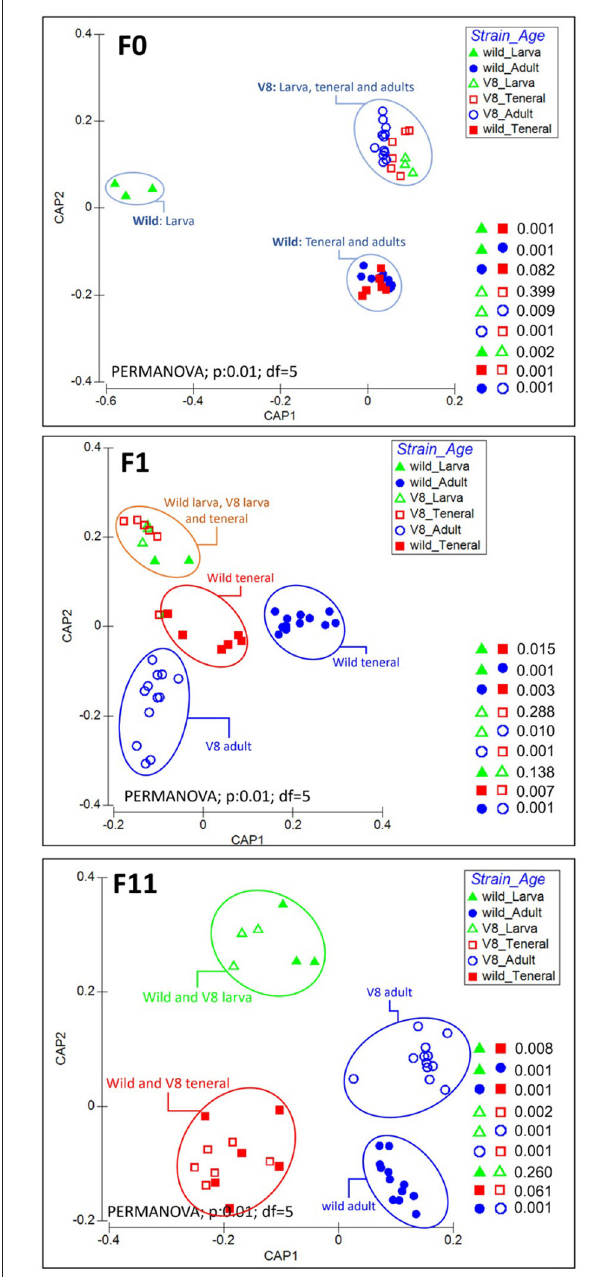
FIGURE 8 | Changes in the bacterial community structure associated with the guts of larva, teneral, and adults originated from Vienna 8 FD-GSS (V8) and wild C. capitata stains before laboratory adaptation (F0), at F1 and F11 generations. Canonical analysis of principal coordinates (CAP) analysis and PERMANOVA test were performed based on GUniFrac dissimilarity